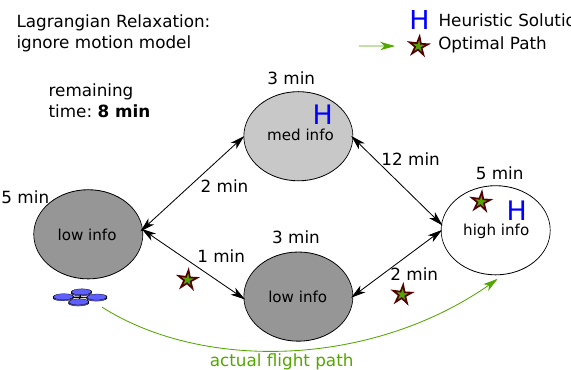
Figure 3. An illustration highlighting how the heuristic is an upper bound. Relaxing the motion model is akin to allowing the agent to move freely between regions ignoring the motion model. The heuristic is able to sample the regions with the most information given the mission duration but ignores path constraints, such as having to navigate the 12 min edge. The optimal solution is to traverse the bottom of the